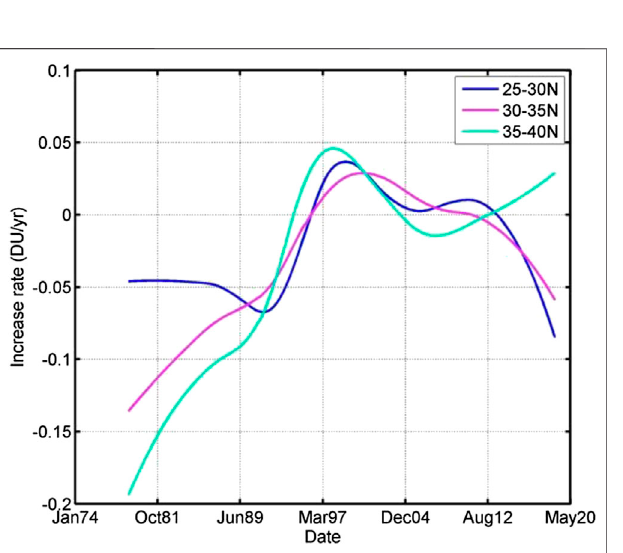
FIGURE 4 | Monthly increase rates of TCO over 30 ° N – 35 ° N latitudinal zone over the TP and its comparison to its south at 25 ° N – 30 ° N and north at 35 ° N – 40 °